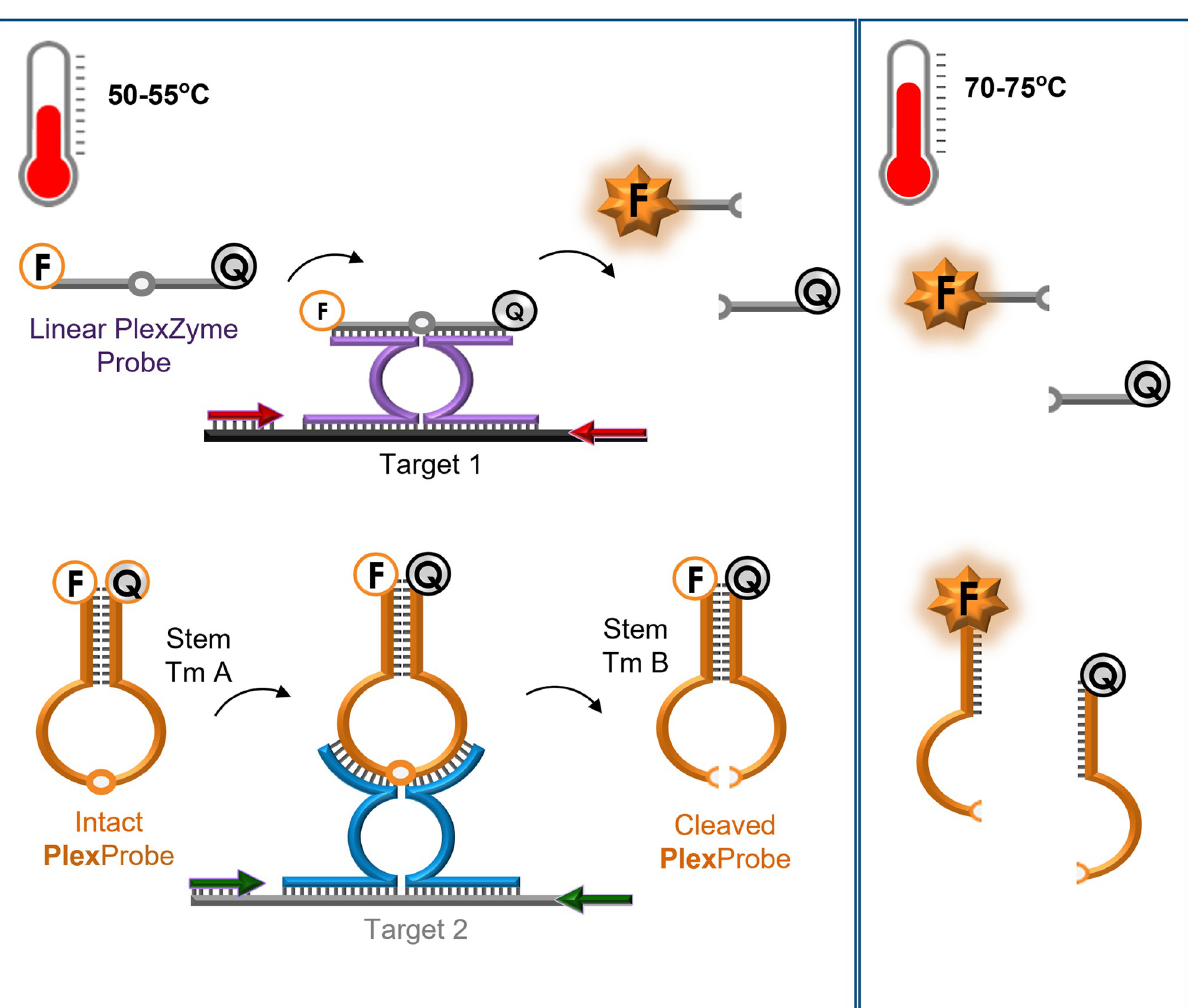
Fig 1. Overview of PlexProbe PCR method. Structure of Linear PlexZyme Probes (grey) and PlexProbes (orange) prior to, and following, cleavage by PlexZymes. Left Hand Side: Structures at temperature range 1 (50–55˚C). Right Hand Side: Structures at temperature range 2 (70–75˚C). Linear PlexZyme Probes and PlexProbes are labelled with the same fluorophore (F) and quencher (Q) dye pair. During PCR, PlexZyme 1 (purple) assembles in the presence of Target 1 (black) and PlexZyme 2 (blue) assembles in the presence of Target 2 (grey). Intact PlexProbes contain a stem region with a Tm A whereas Cleaved PlexProbes have stems with a Tm B which is lower than Tm A.